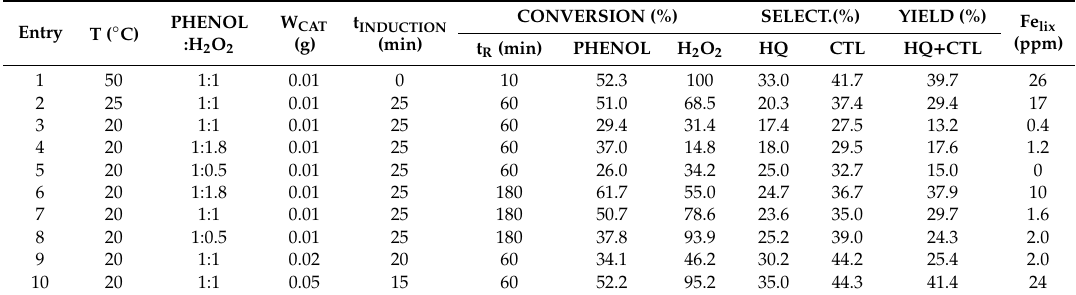
Table 1. Catalytic performance of Fe-BTC upon the hydroxylation of phenol at di ff erent operating conditions.